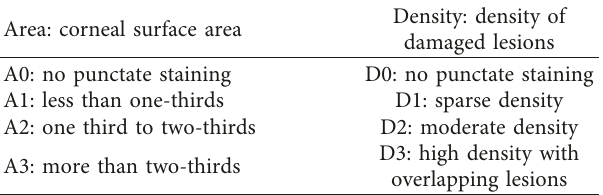
Table 1: Classification of severity in corneal epithelial